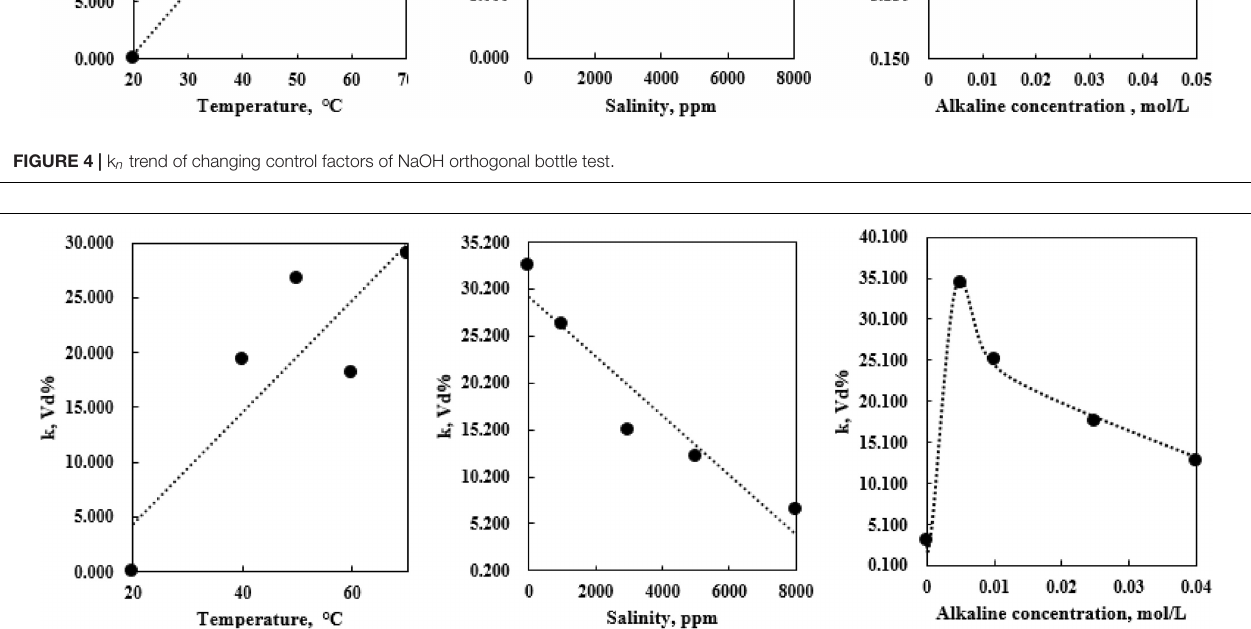
FIGURE 5 | k n trend of changing control factors of Na 2 CO 3 orthogonal bottle test.